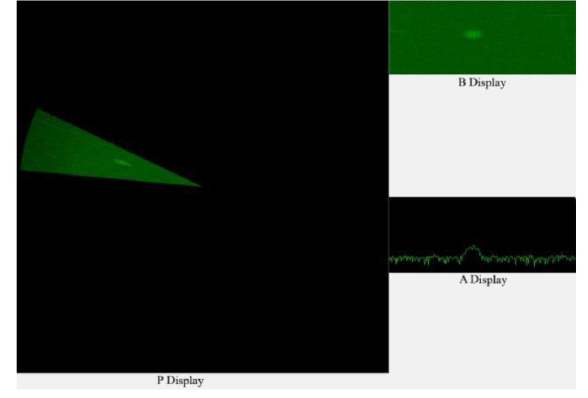
Fig. 9 The echo of Ship B.